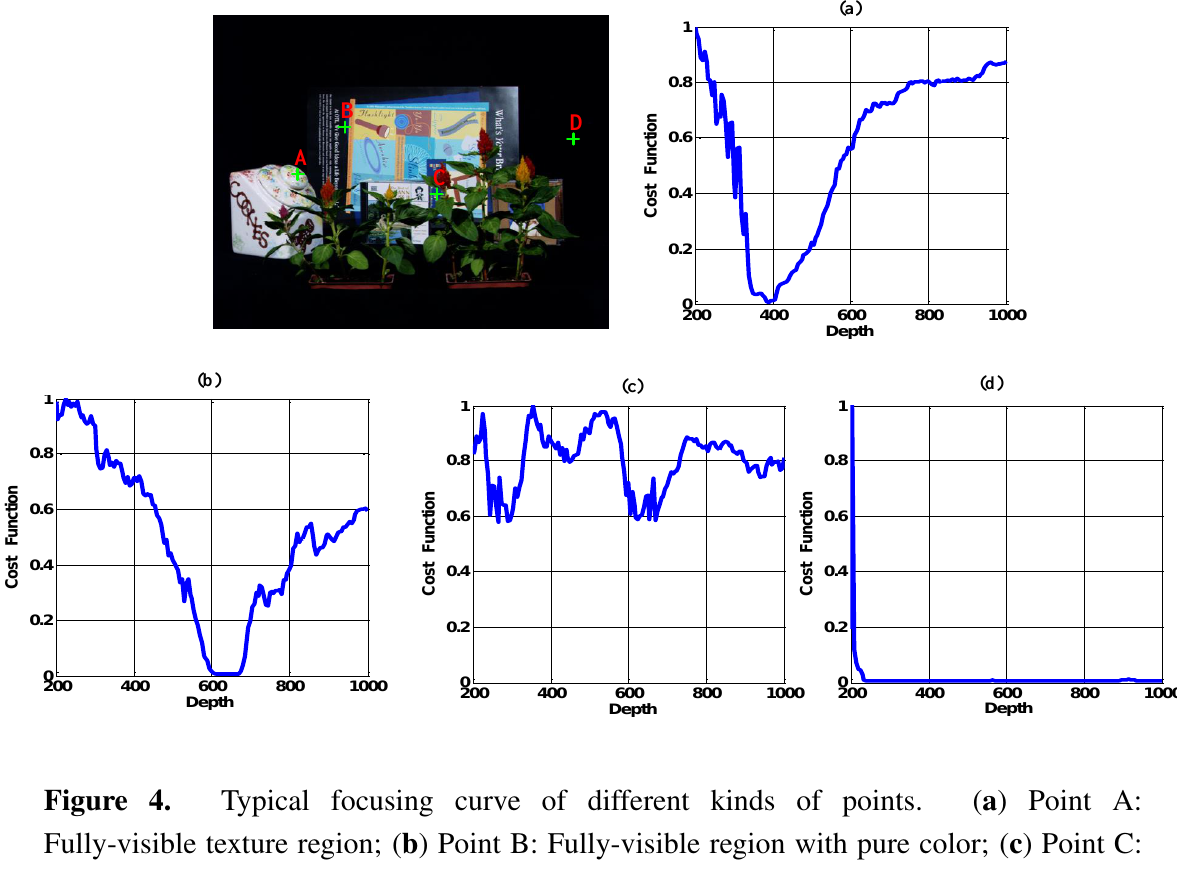
Figure 4. Typical focusing curve of different kinds of points. ( a ) Point A: Fully-visible texture region; ( b ) Point B: Fully-visible region with pure color; ( c ) Point C: Partially-occluded region or free point; ( d ) Point D: Textureless